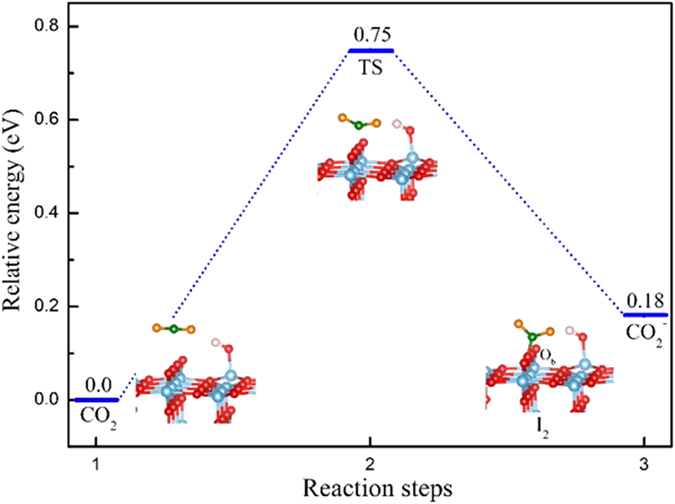
Illustration of reaction pathway to form CO2+ cation.The sum energy of CO2 and TiO2 is set to zero as the reference energy.